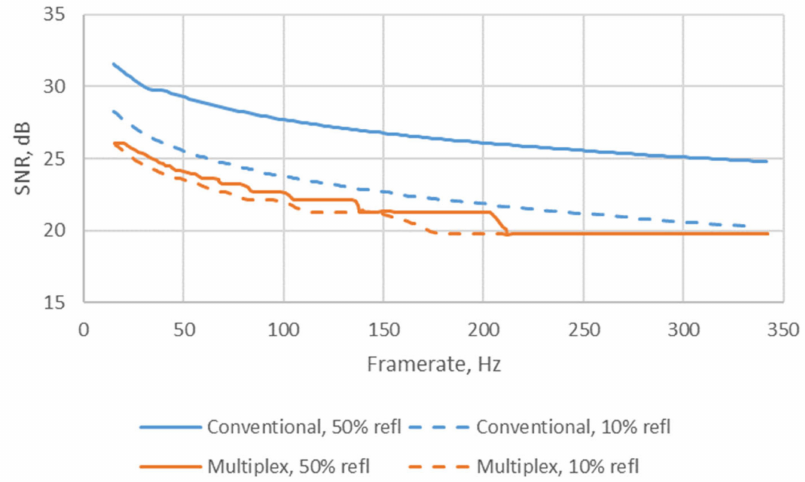
Figure 9. Shows the SNR behavior of the conventional spectrograph sensing vs. the CA multiplexed sensing for the SWIR sensing system, at an illumination of 60 ◦